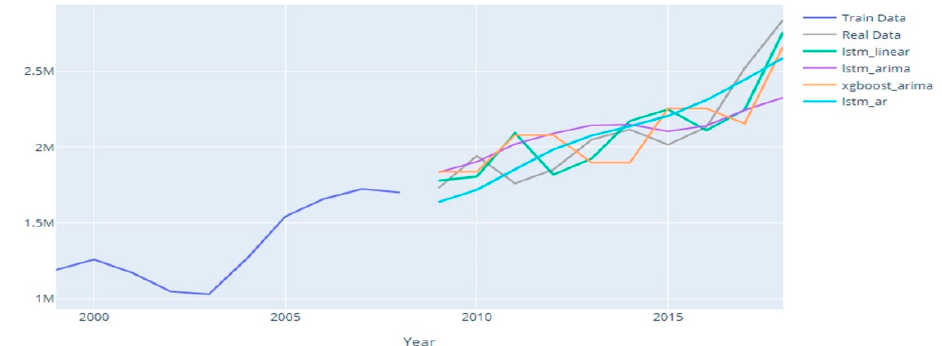
Figure 6. Forecasting results for the Marrakech-Safi region using the hybrid models.